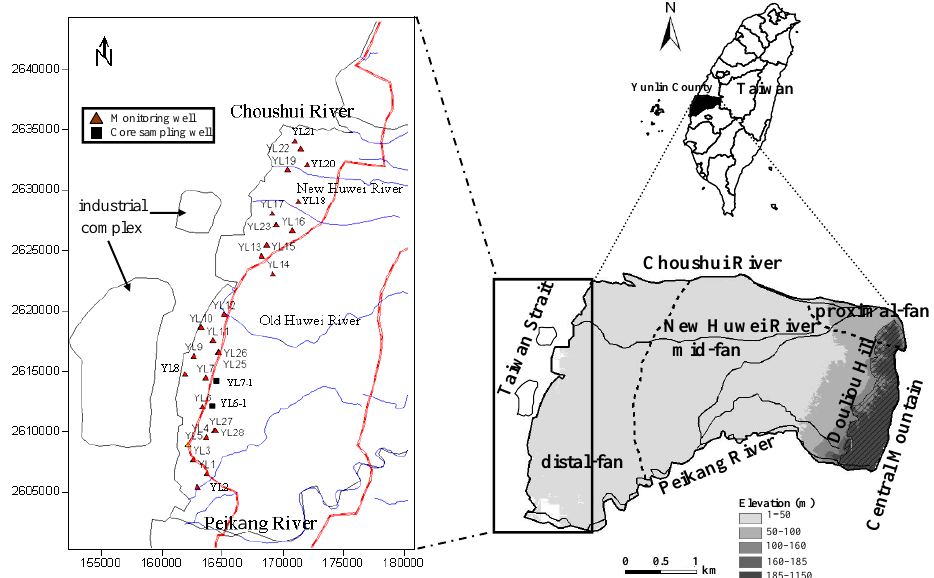
Fig. 1. Location of study area in the coastal area of the Choushui River alluvial fan, Taiwan. Triangle and square symbols represented groundwater and core sampling wells, respectively. Offshore industrial complexes are man-made islands for oil refinery